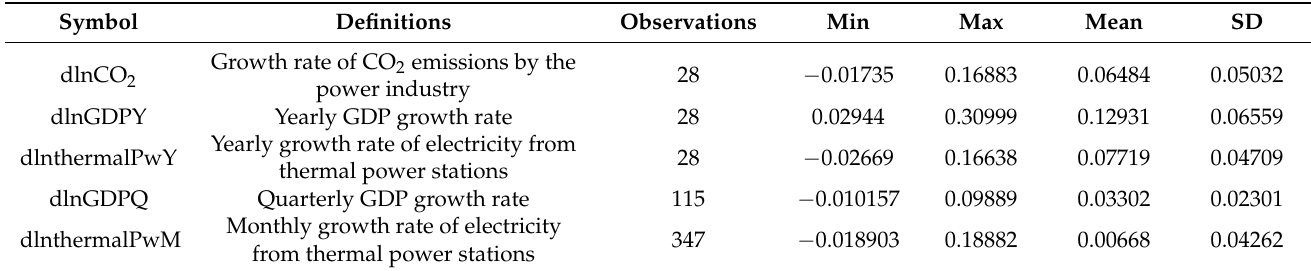
Table 2. Definitions of first-order differenced data and statistical